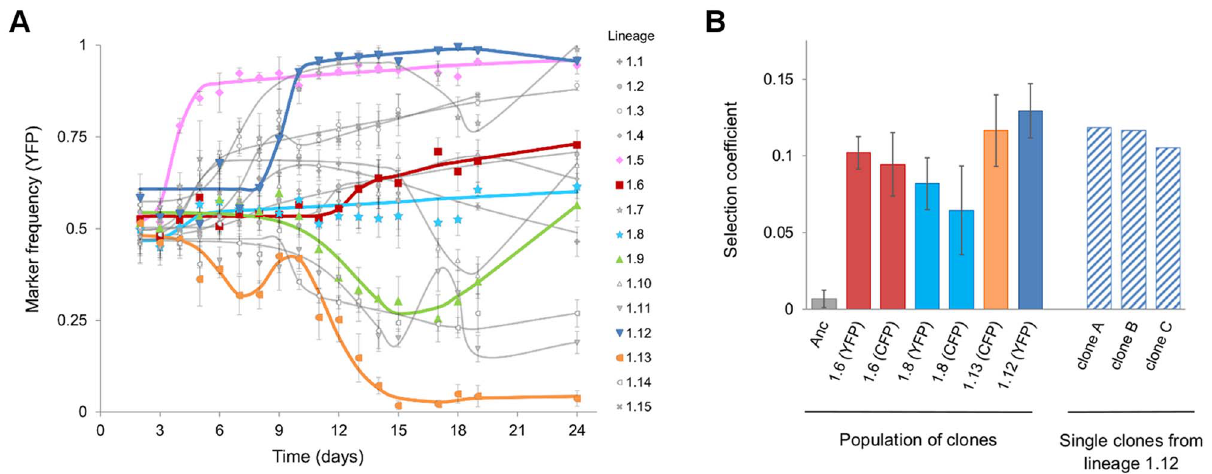
Figure 1. Evidence for rapid adaptation and CI invivo . A ) Dynamics of marker frequency (with 95% confidence intervals) during the adaptation of E. coli to the gut upon colonization (populations 1.1 to 1.15). The predictions of the simplest model of Darwinian selection [22], for each set of data points are shown as lines. The lines correspond to the model that assumes multiple beneficial mutations ( i =1,2,5) can occur in a given clone at a given time ( Tb i ), and these clones have a given fitness ( W i ). Tb i and W i are fitted by maximum likelihood and the best model, in terms of number of mutations, is chosen according to Akaike criteria. Representative examples of trajectories for the classical signature of a selective sweep (populations 1.5, 1.12 and 1.13) and for the maintenance of neutral diversity under with intense CI (populations 1.6, 1.8 and 1.9) are shown in colours. B ) Direct evidence for adaptation and CI: the bars represent the mean selection coefficient ( 6 2 s.e.m, n=3) from an in vivo competitive fitness assay between evolved and ancestral clones. The first bar shows the neutrality of the fluorescent marker. The following six bars represent the results from competitions of a mixture of thirty clones (with a given fluorescent marker, indicated below the bar) isolated from the respective population (indicated below each bar). Both CFP and YFP mixtures of clones from lineages 1.6 and 1.8 show similar levels of adaptation, consistent with intense CI maintaining a high frequency of both neutral markers. The dashed bars show the results of competitions (n=2) of single clones isolated from lineage 1.12.